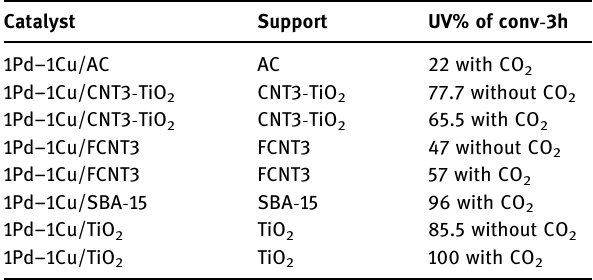
Table 4: Nitrates conversion ( % ) analyzed by UV - Vis after 3 h of catalytic reduction using the supported catalysts: 1Pd – 1Cu/FCNT3, 1Pd – 1Cu/TiO 2, 1Pd – 1Cu/CNT3 - TiO 2, 1Pd – 1Cu/SBA - 15, and 1Pd – 1Cu/